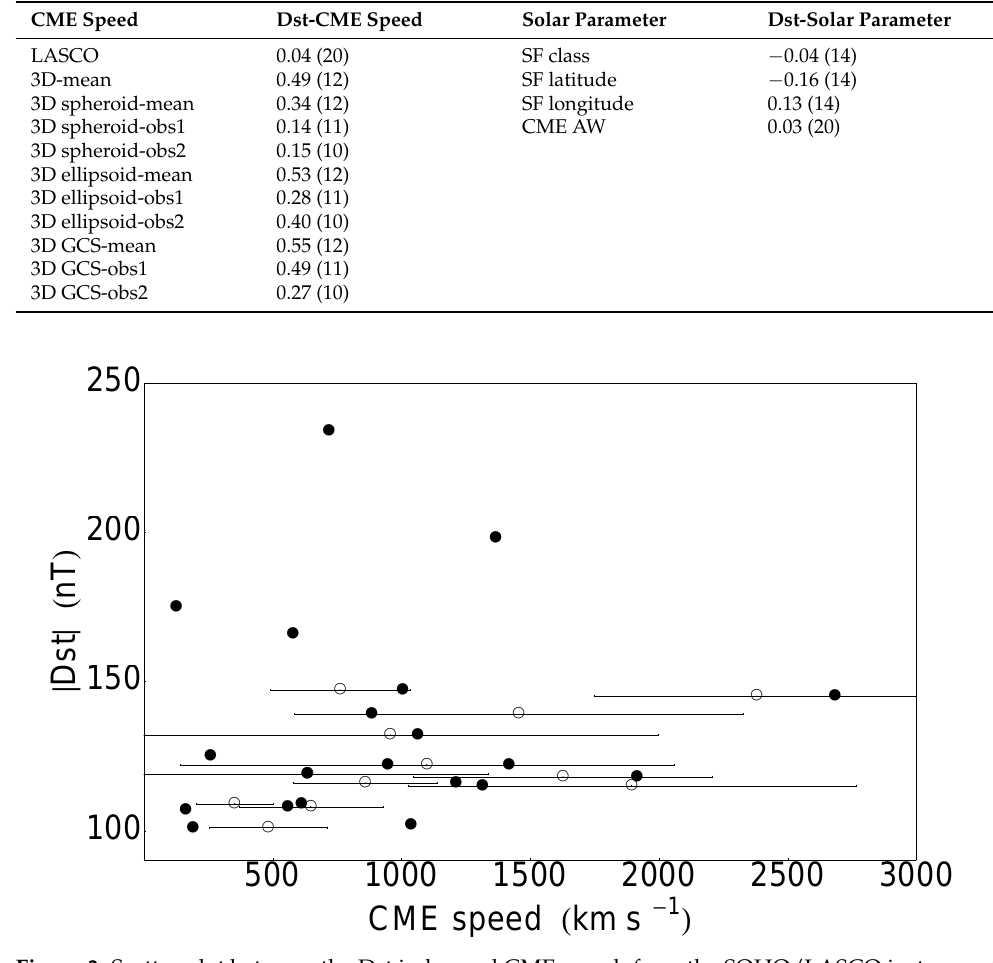
Figure 3. Scatter plot between the Dst index and CME speed: from the SOHO/LASCO instrument (with filled circles) and from the 3D de-projections (with empty